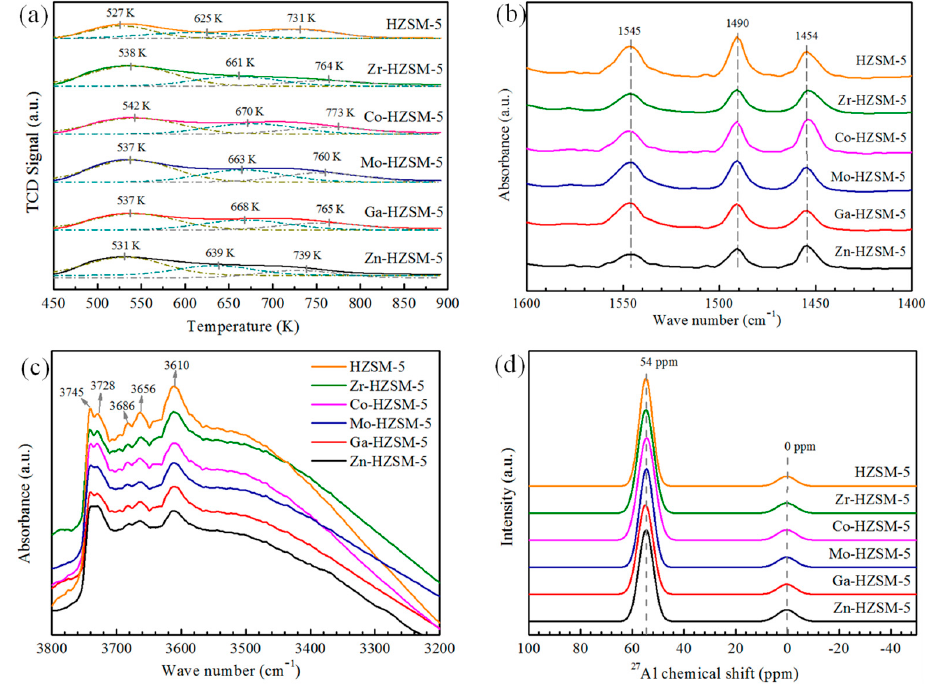
Figure 4. ( a ) NH 3 -TPD profiles, ( b ) Py-IR spectra, ( c ) FTIR spectra in hydroxyl group regions, ( d ) 27 Al MAS NMR spectra of the catalysts with hydrogen pre-treatment at 873 K for 2